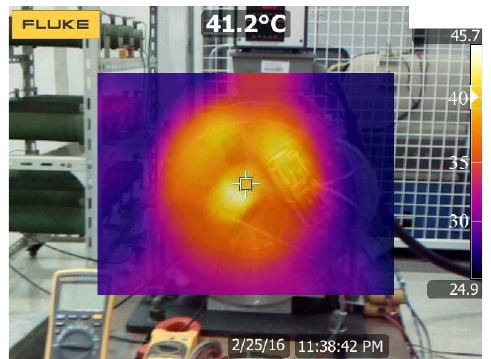
Figure 18. Schematic diagram of temperature when the excitation current is 1 A.